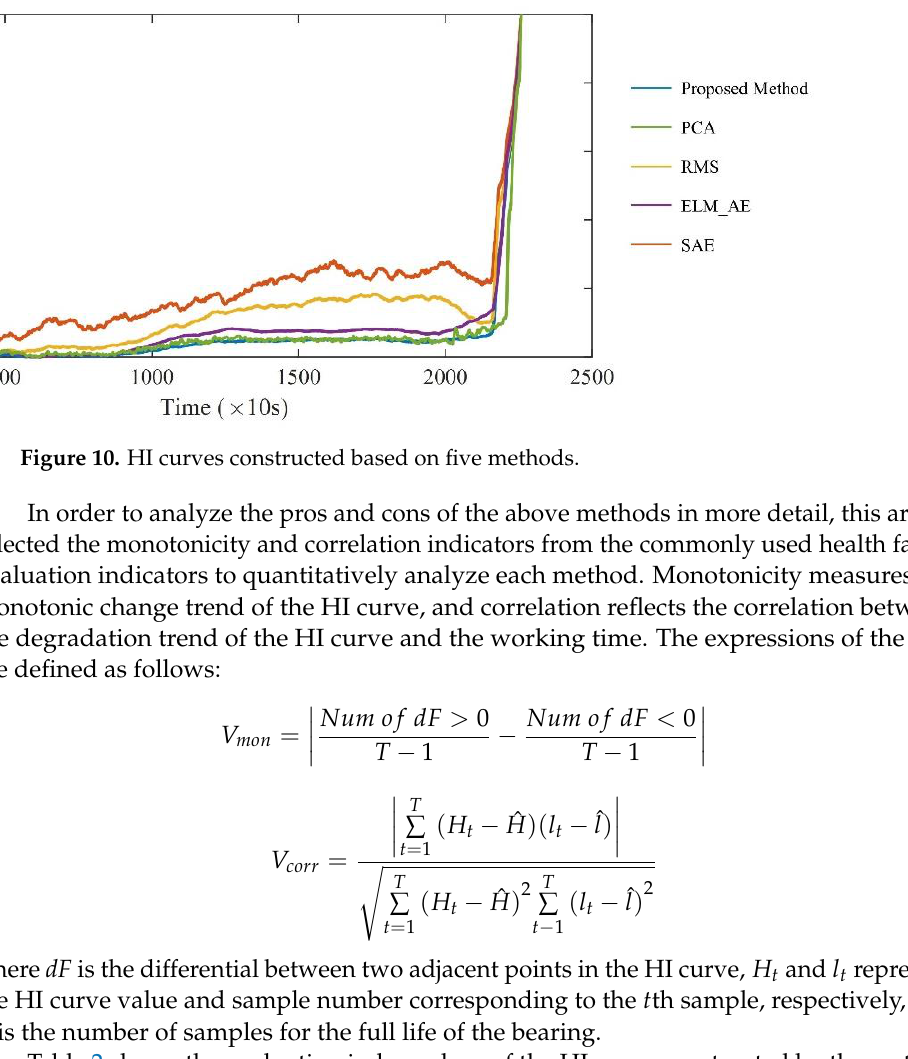
Table 2. HI curve evaluation results.